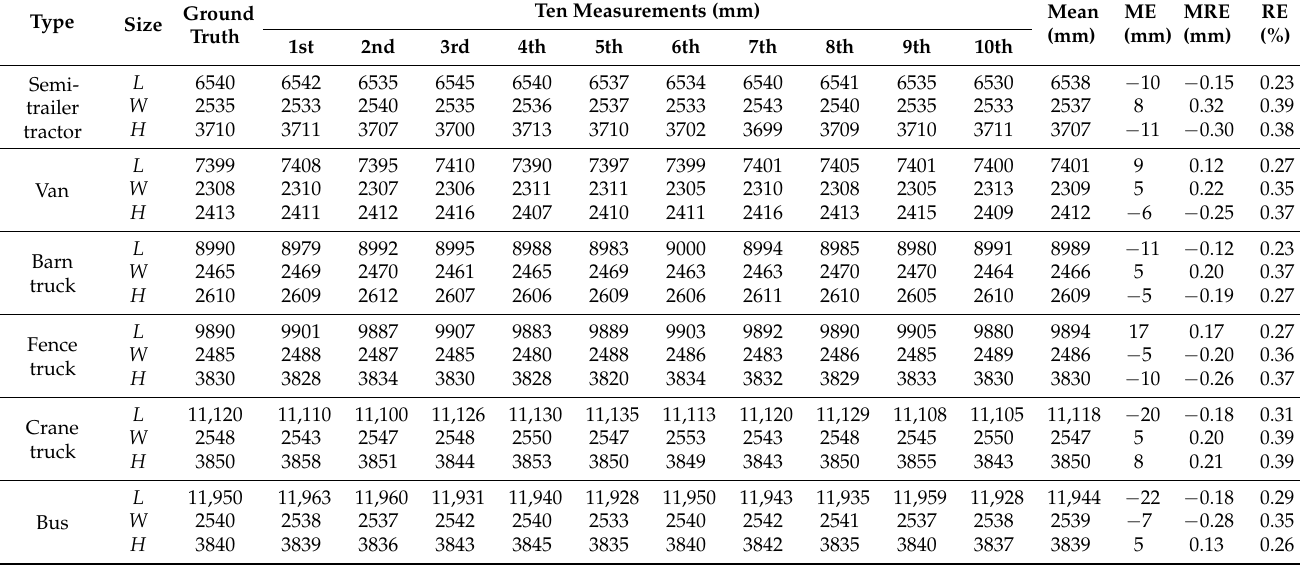
Table 2. Experimental results of generality and repeatability of